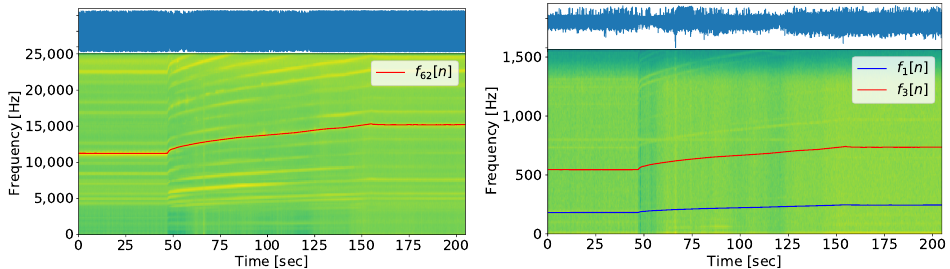
Figure 4. Spectrograms of ACC2 record estimated within full frequency range of [ 0,25 ] kHz ( left ), and for downsampled version (by 16 times) within [ 0,1.56 ] kHz ( right